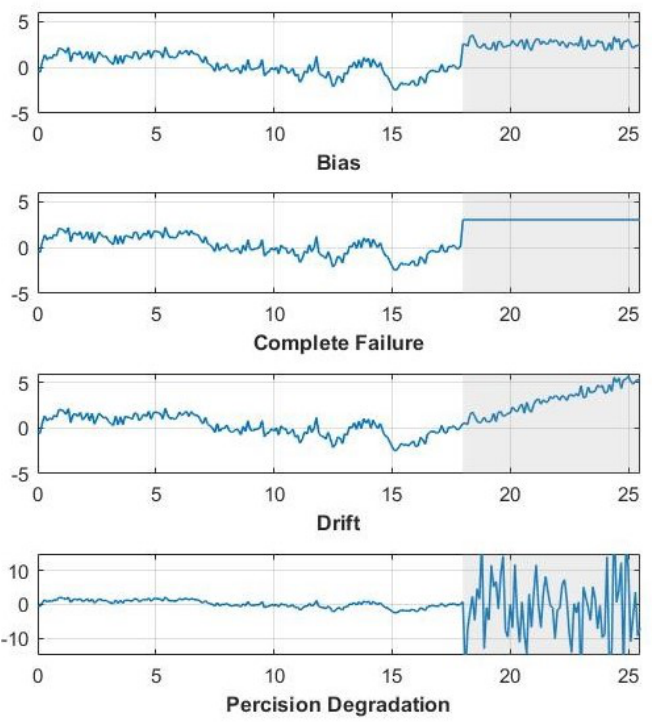
Figure 16. Illustration of different sensor faults in C AF .